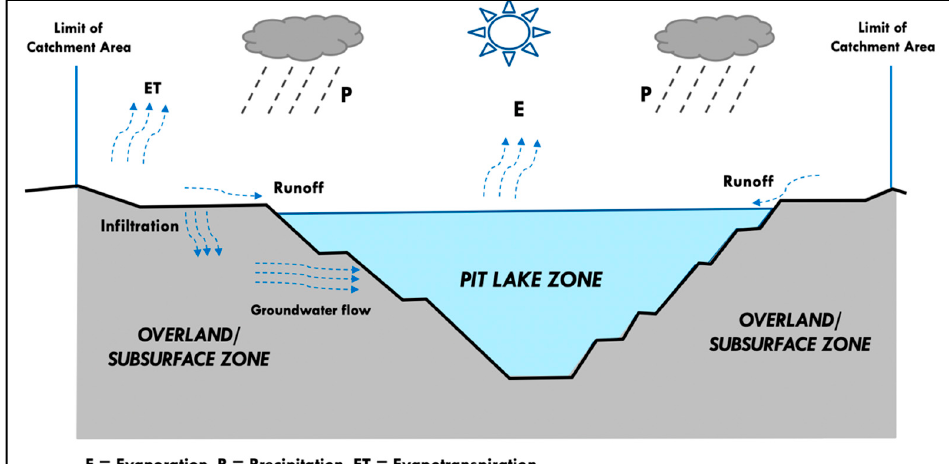
Figure 3. Conceptual water balance calculation.